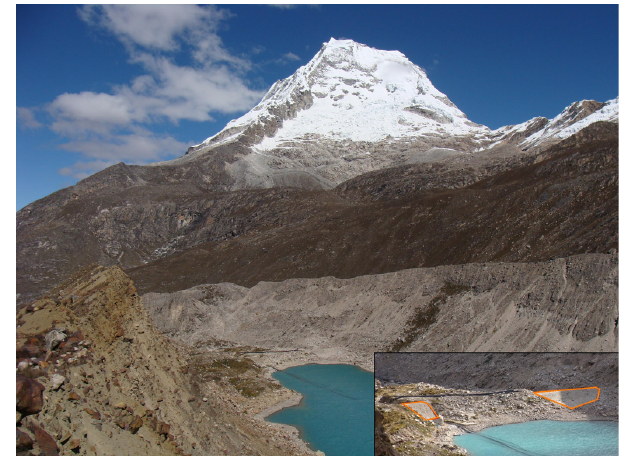
Fig. 5. The artificial dam and armoured outflow of Lake Llaca; the dam freeboard is 12m.